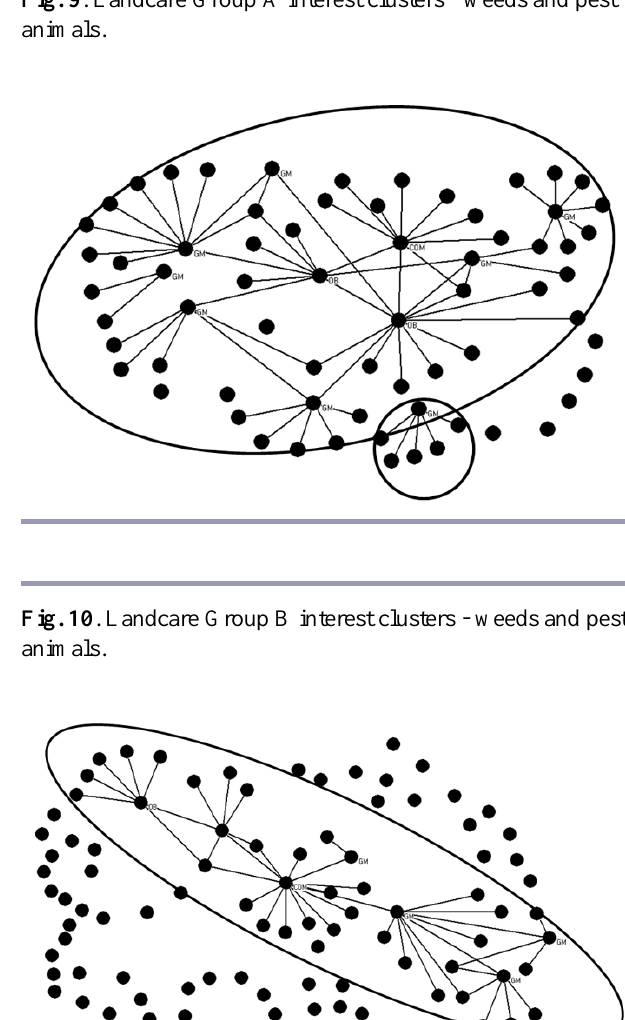
Fig. 9 . Landcare Group A interest clusters - weeds and pest animals.